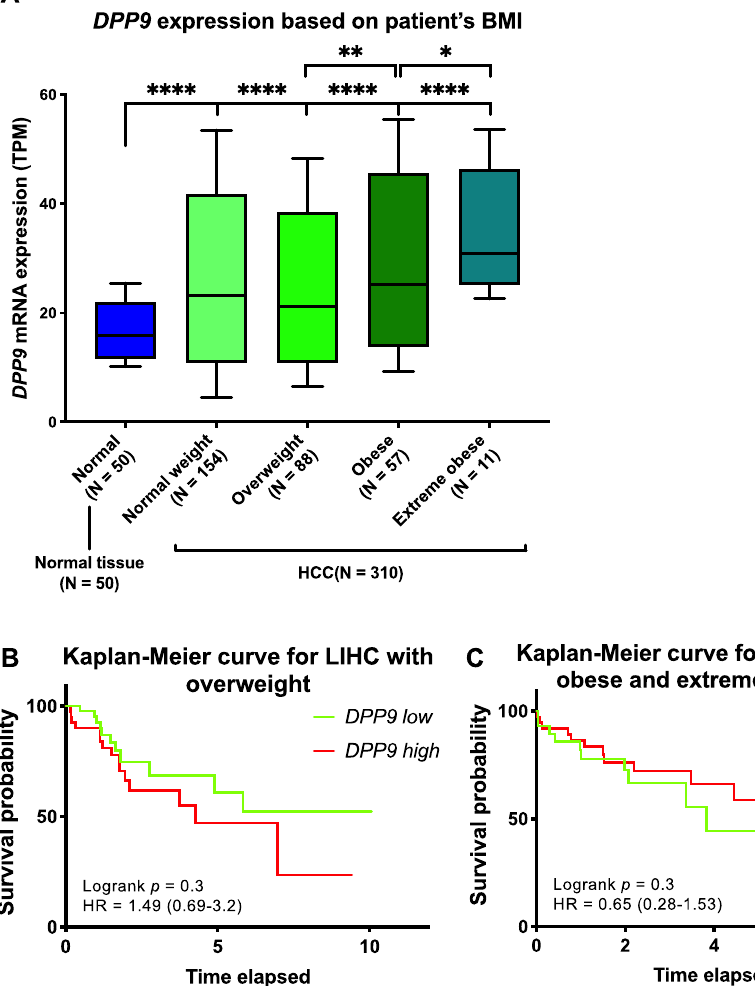
Figure 3. The relative mRNA expression and survival analysis of DPP9 in HCC based on patient BMI. ( A ) The mRNA expression of DPP9 based on HCC patient ( n = 360) BMI compared to non-diseased subjects. p values were calculated by Kruskal-Wallis one-way analysis of variance with Tukey’s post-hoc test, with * p < 0.05, ** p < 0.01, **** p < 0.0001. ( B ) Kaplan-Meier curve for DPP9 expression in overweight HCC patients. ( C ) Kaplan-Meier curve for DPP9 expression in obese and extreme obese HCC patients. The high (red) and low (green) mRNA expression levels of genes in liver tumors were stratified based on median expression value. p values and hazard ratio (HR) with confidence interval were calculated by logrank (Mantel-Cox) test.